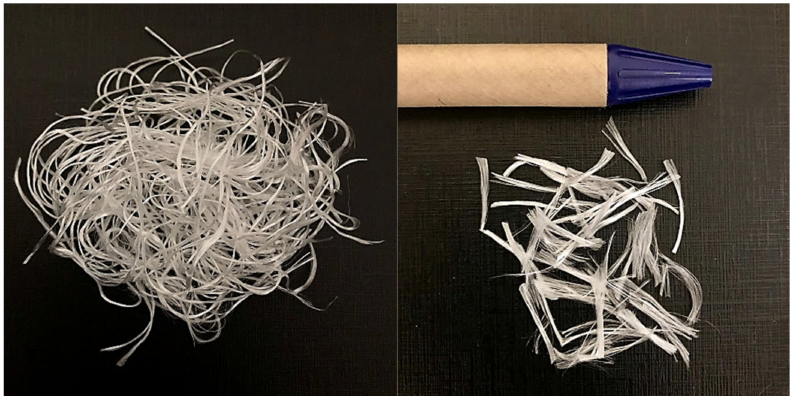
Figure 1. PET fiber used as